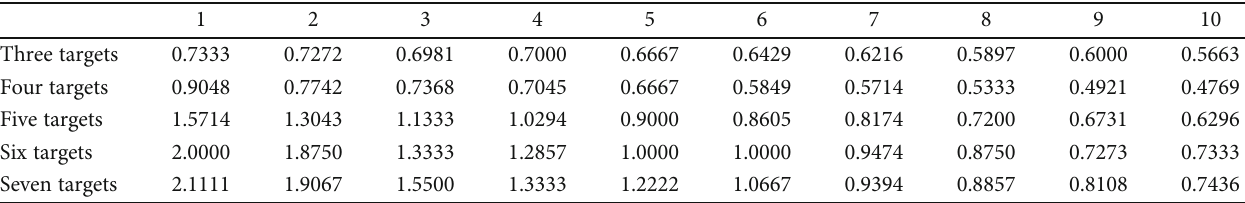
Table 4: MI lifting rate of robust waveform based on harmonic variance relative to the optimal transmitted waveform in the uncertainty range with di ff erent target